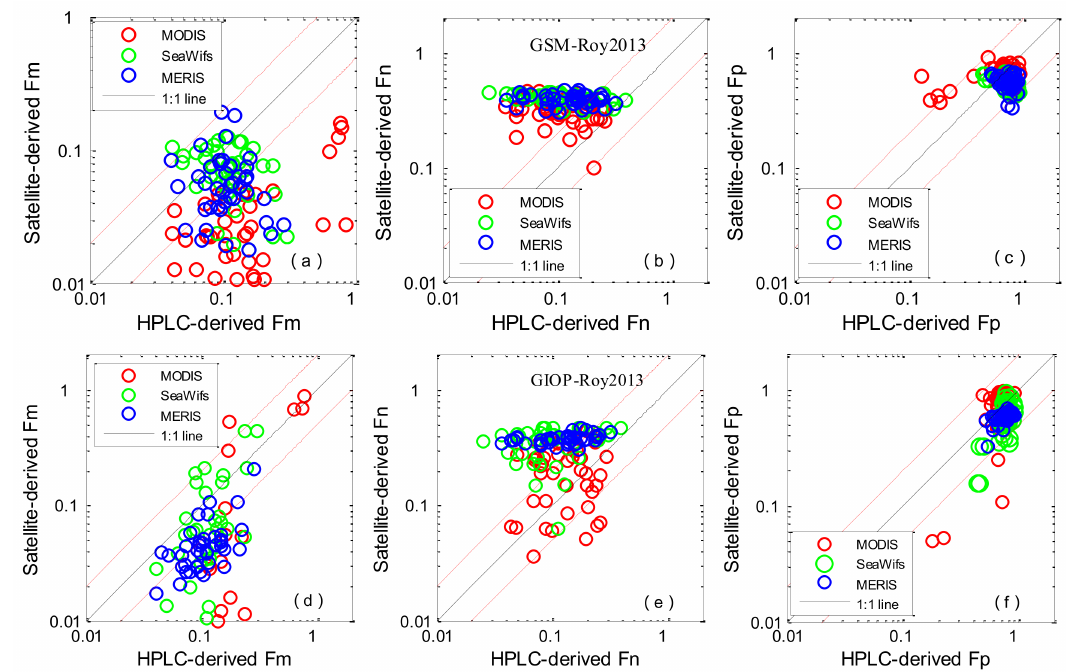
Figure 6. Scatter plots of satellite-derived (Roy2013) PSCs versus in situ measurements: a ph (676) was estimated by the Garver–Siegel–Maritorena (GSM) model ( a – c ); a ph (676) was estimated by the Generalized Inherent Optical Property (GIOP) model ( d – f ). The solid line is the 1:1 line. The red dashed lines are the 1:2 and 2:1 lines. Table 5. Statistical results for the validation of abundance-based algorithms for MERIS, MODIS and SeaWiFS. The slope is the linear regression results from retrievals versus in situ ones. N is the number of